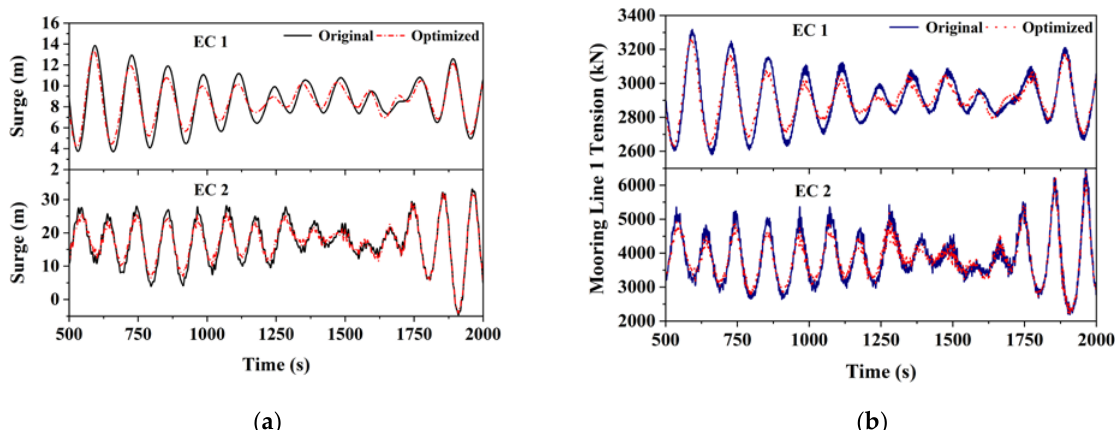
Figure 12. ( a ) The surge responses of the two wind turbines in two sea conditions in the time domain; ( b ) the ML1 tension for the two wind turbines in two sea conditions in the time